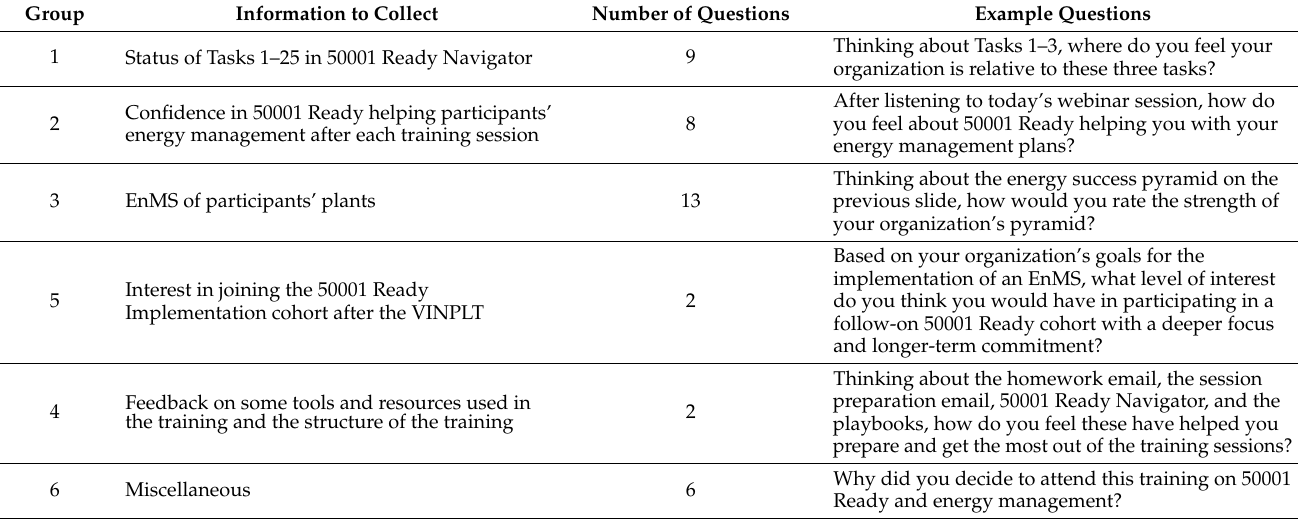
Table 2. Six groups of polling questions (source: author’s development).